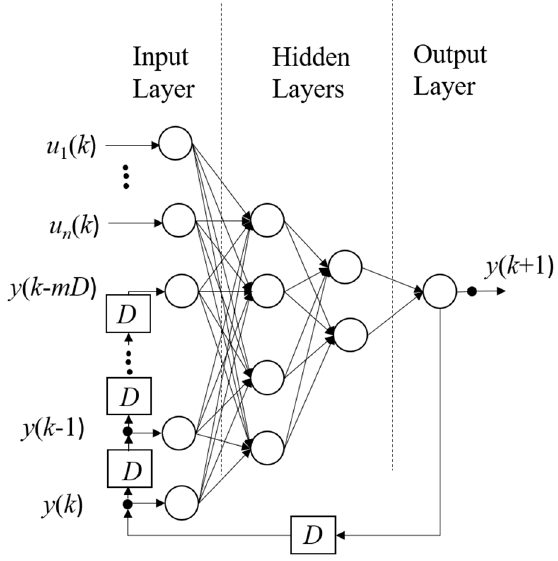
Figure 2. Exemplary model of a nonlinear autoregressive model with exogenous inputs.